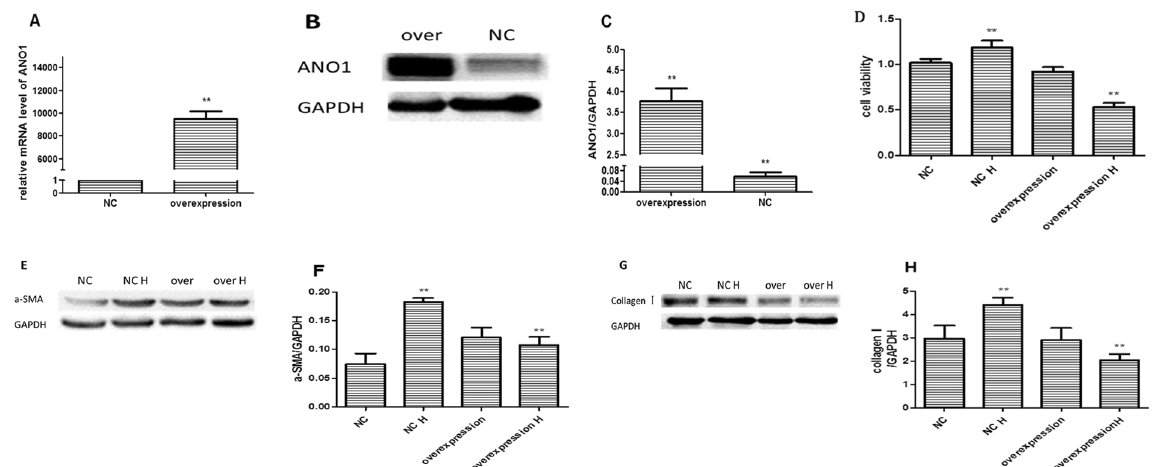
Figure 4. Overexpression of ANO1 reduced the indicators of cardiac fibrosis after hypoxia. ( A ) Ano1 mRNA was dramatically increased in ANO1 overexpression group comparing to negative control (NC) group by qRT-PCR. ( B and C ) ANO1 protein expression were dramatically increased in ANO1 overexpression group comparing to NC group by western blotting assay. ( D ) MTT analysis showed that cell viability elevated in overexpression ANO1 + hypoxia 16 hours (overexpression H) group comparing to overexpression ANO1 (over H) group and negative control (NC) + hypoxia 10 hours (NC H) group. ( E and F ) Expression of a-SMA protein was reduced in overexpression H group comparing to overexpression group and NC H group by western blotting. ( G and H ) Expression of collagen I protein was reduced in overexpression H group comparing to overexpression group and NC H group by western blotting. * p < 0.05, ** p <